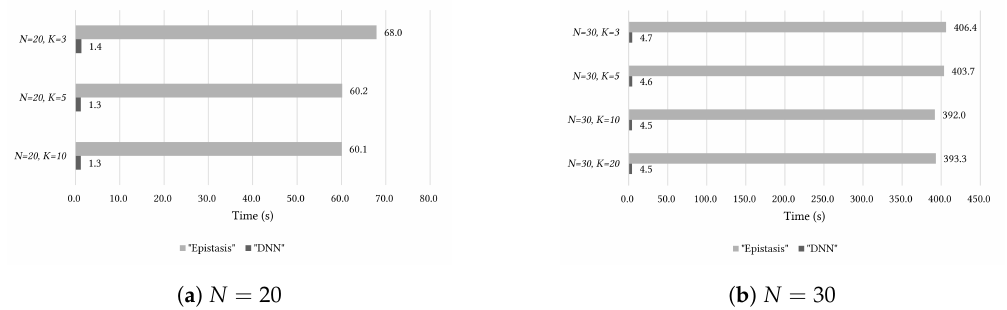
Figure 8. Comparison of processing time for the experiments in this study (“DNN”) and previous study (“Epistasis”) on the NK -landscape problem.